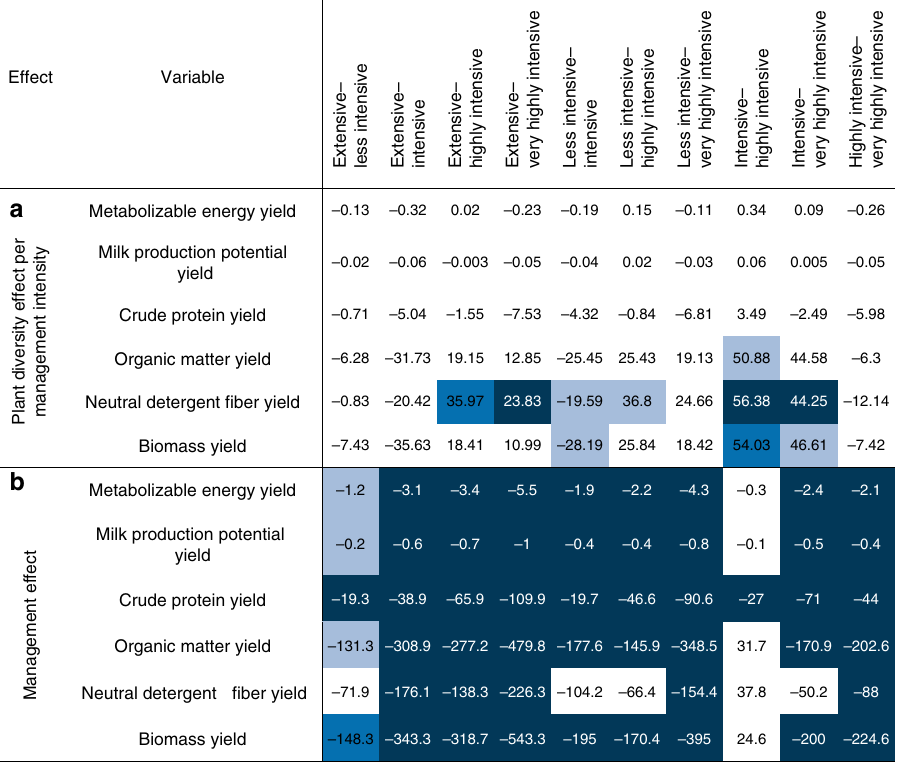
Fig. 3 Differences between plant diversity effects per management intensity and management effects. The fi gure shows differences and signi fi cance of the differences between a plant diversity effects per management intensity and b management effects on quality-adjusted yield (g or MJ or kg m − 2 a − 1 ) and biomass yield (g m − 2 a − 1 ). Pairs of management intensities indicate the management intensities compared to each other. The displayed numbers are the differences between the effects of the compared management intensities. Light blue, mid blue, and dark blue denote signi fi cance at the 5%, 1%, and 0.1% level, respectively (corrected for multiple comparisons), and white denotes no signi fi cant effect at the 5% level. The signi fi cance levels are based on the Wald test. Note that utilizable crude protein content was only measured for the fi rst cut of the year, which is why we do not compare it between management intensities. The fi gure is based on Supplementary Tables 3 – 8.